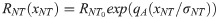
Topographic mapping implemented by growth cone chemotaxis.(A) The receptors were activated by guidance cue binding. Dose-response of receptor activation was plotted in right panel. (B) The chemotactic growth cone in (A) prefers a specific ligand concentration that is inversely proportional to the receptor expression level. (C) Linear topographic mapping was produced by an EphA gradient along the retinal nasal-temporal (NT) axis and an ephrinA gradient along the tectal rostral-caudal (RC) axis. Dashed arrows indicate corresponding receptor expression levels and preferred ligand concentrations. The applied gradients were RNT(xNT)=RNT0exp(qA(xNT/σNT)) and GRC(xRC)=GRC0exp(−qA(1−xRC/σRC)). (D) Two possible molecular mechanisms by which the guidance cue is transduced to an intracellular signal through the receptor. (D(i)) Guidance cue-unbound receptors were active. (D(ii)) Two kinds of receptors competitively bind the guidance cue so that these receptors effectively suppress each other. (E) The chemotactic growth cone in (D) prefers a specific ligand concentration that linearly increases with the receptor expression level. (F) Linear topographic mapping was produced by an EphB gradient along the retinal dorsal-ventral (DV) axis and an ephrinB gradient along the tectal medial-lateral (ML) axis. The applied gradients were RDV(xDV)=RDV0exp(qB(xDV/σDV)) and GML(xML)=GML0exp(qB(xML/σML)).